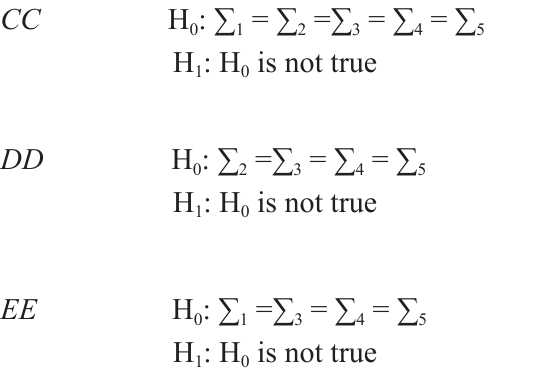
Table 3 : Test statistics for hypotheses tests on variance- covariance matrices for mean distance refractive state using MANOVA. The respective null hypotheses are stated in example 2. Critical values are Table 5 : Test statistics for hypotheses tests on mean distance (for CC :  2 0.05, 24 = 36.415 and  2 0.01, 24 = 42.980) and refractive state using MANOVA. The respective null hypoth- (for DD and EE :  2 0.05, 18 = 28.869 and  2 0.01, 18 = 34.805). eses are stated in example 3. Critical values are Hypothesis test and value Test statistic using equation 32 2 , (for C :  2 0.05, 12 = 21.026 and  2 0.01, 12 = 26.217) and of k in brackets (for D and E :  2 0.05, 9 = 6.919 and  2 0.01, 9 = 21.666). Hypothesis test and value of Test statistic using equation 32 2 , k in brackets with decision on H 0 denoted by * and **